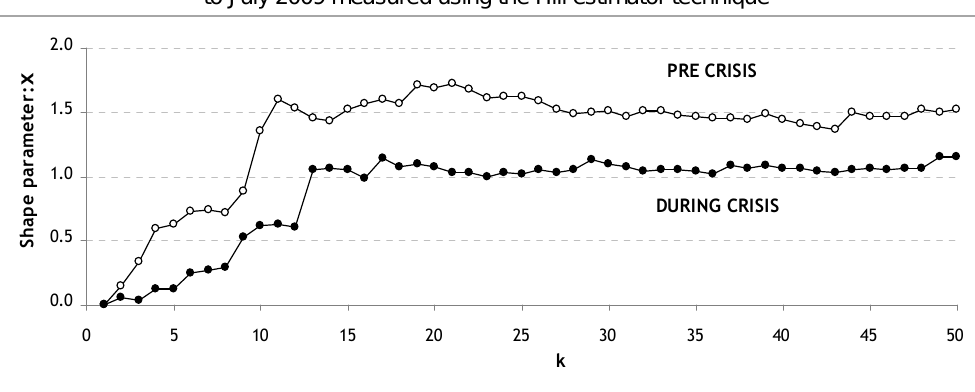
Comparison of shape parameters for the period January 2003 to June 2007 and July 2007 to July 2009 measured using the Hill estimator